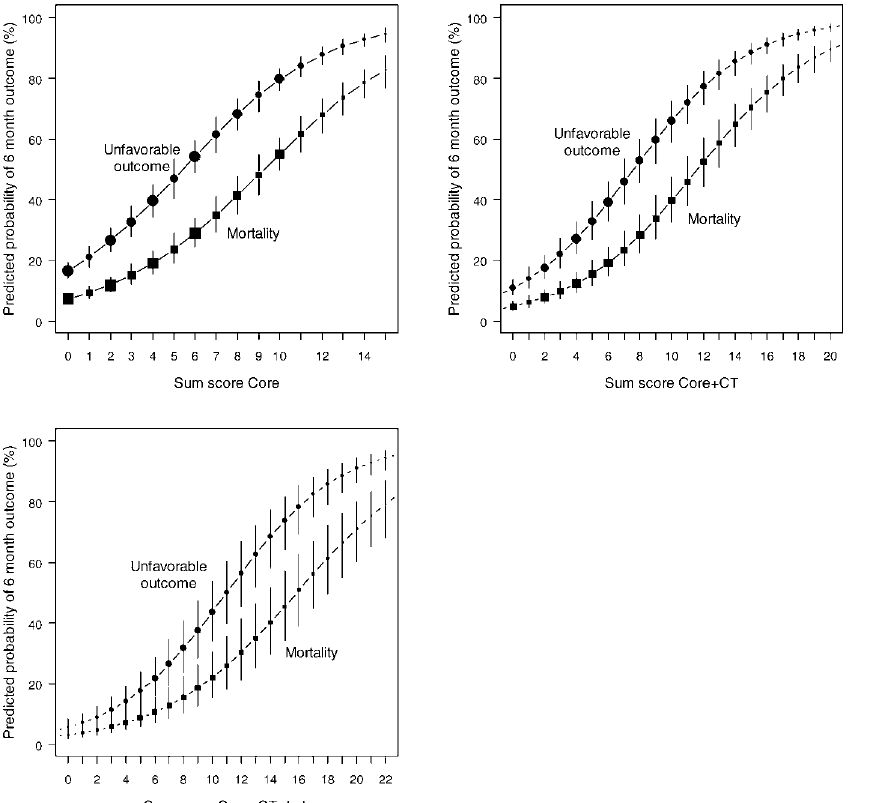
Figure 2. Predicted Probabilities of Mortality and Unfavorable Outcome at 6 Month after TBI in Relation to the Sum Scores from the Core, Extended, and Lab Models The logistic functions are plotted with 95% confidence intervals. Dot size is proportional to sample size. Sum scores can be obtained from Figure 1.